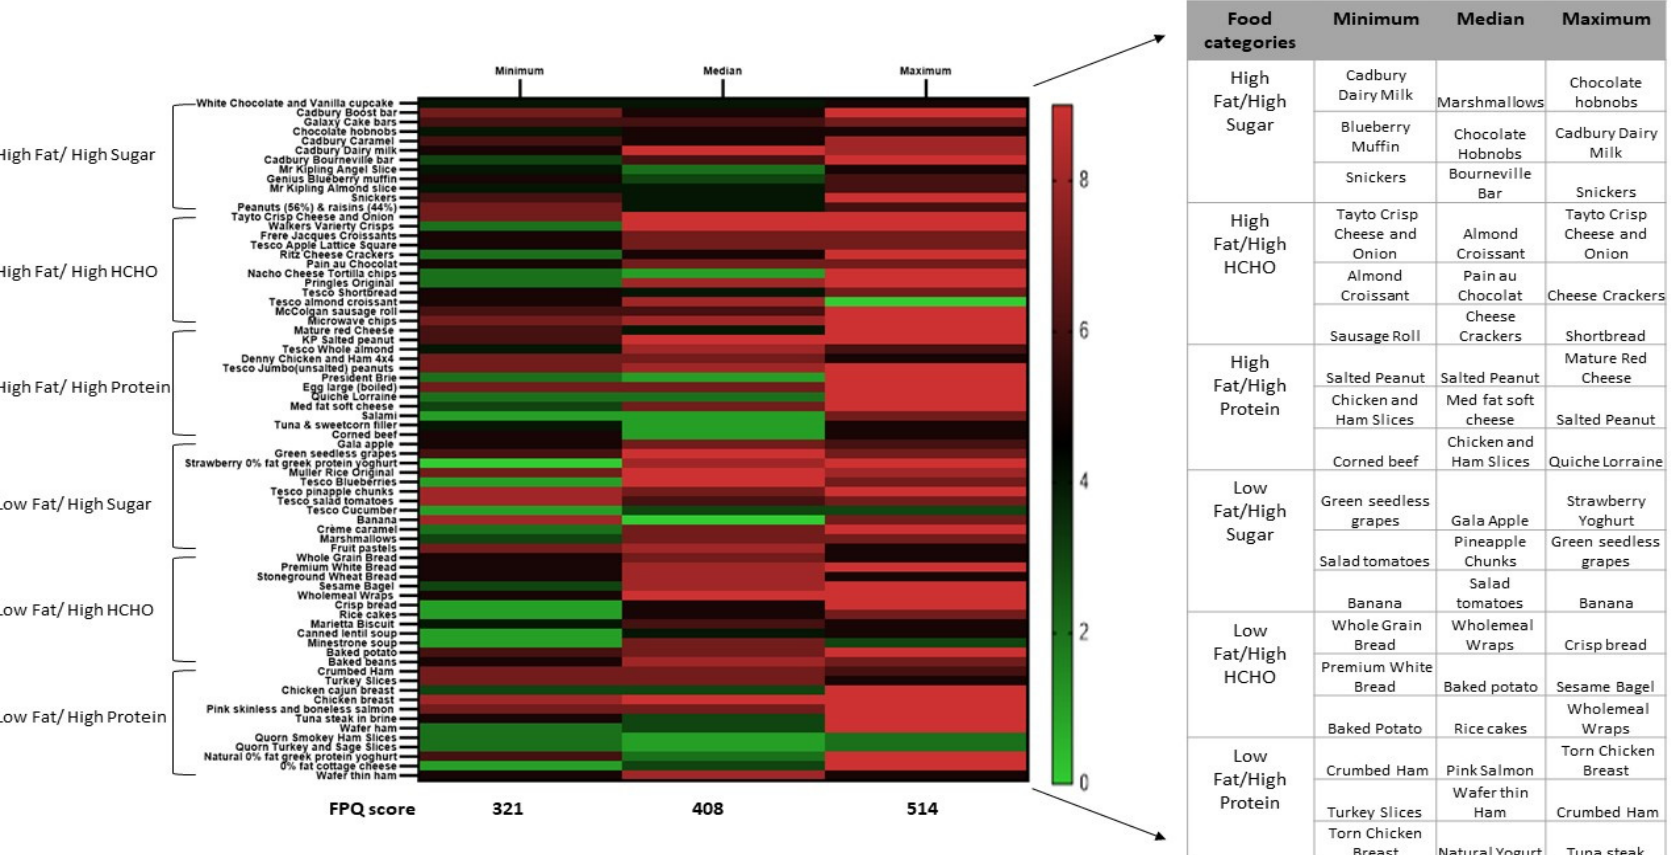
Figure 2. Questionnaire-derived food preference ratings and meal selection. HCHO, High Complex Carbohydrates; FPQ, Food preference questionnaire. The heatmap shows graded preference of the 72 items for three participants (minimum, median and maximum ratings). The colour intensities vary from green to red where green is a score between 0 and 3 and red between 6 and 9 on the Likert scale.